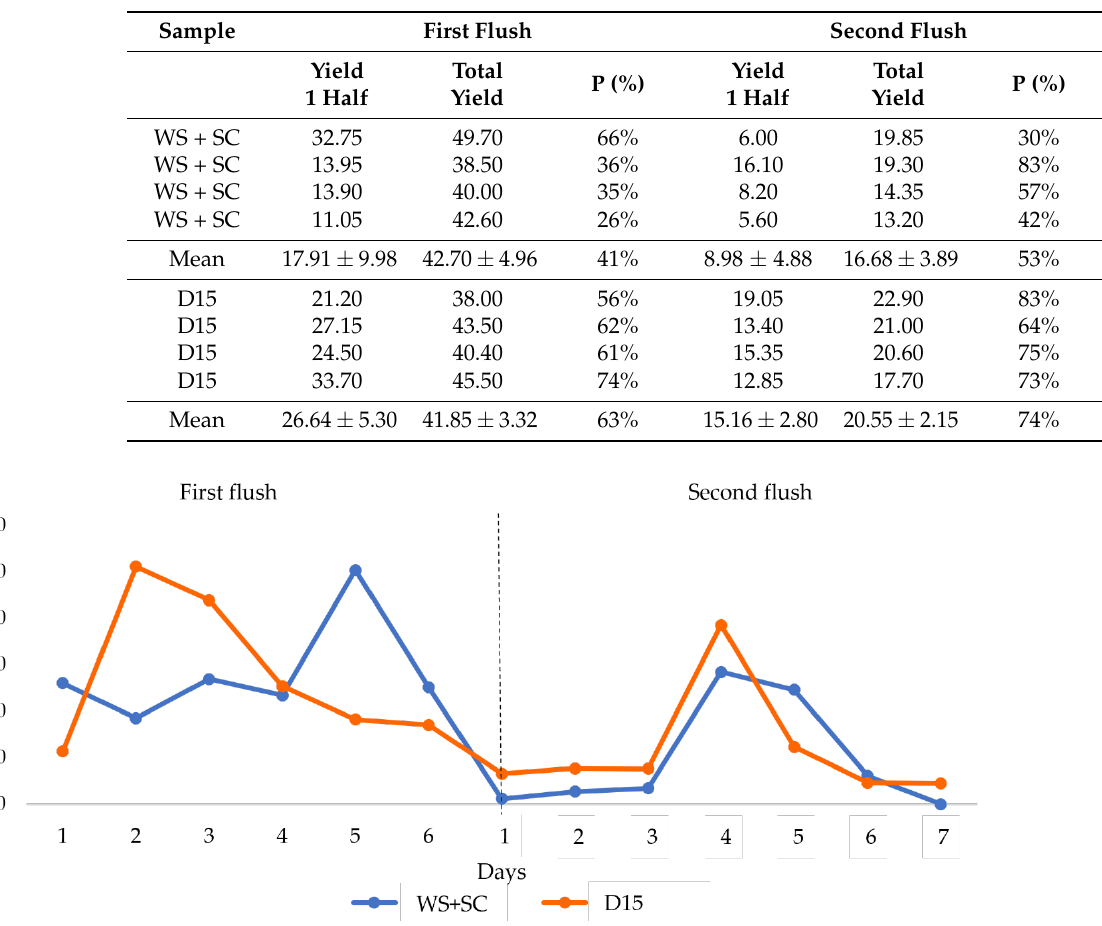
Table 3. Chemical parameters of the fruiting bodies of P. ostreatus harvested from the conventional substrate (WS+SC) and the experimental one (D15).